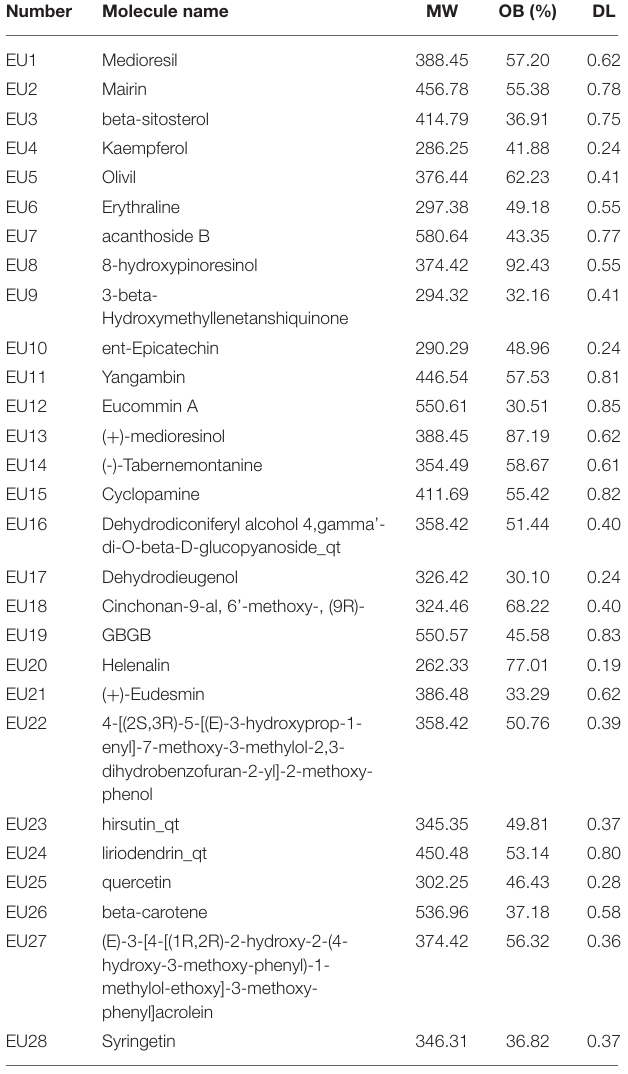
TABLE 1 | Pharmacokinetic properties of candidate compounds of Eucommia ulmoides